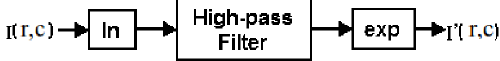
Figure 3. The principle of homomorphic filtering. A logarithmic transform is applied to make the illumination and reflection terms additive, a high-pass filter is then applied, and an exponential trans- form is applied to invert the log transform.